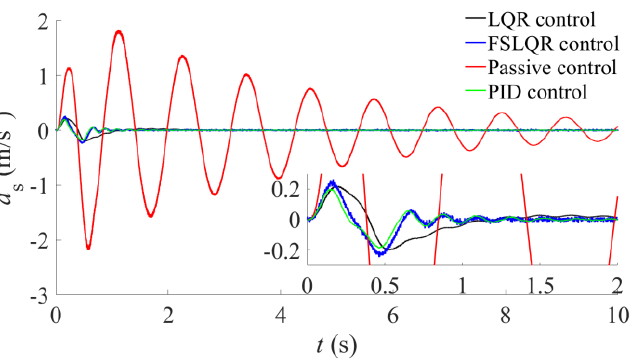
Figure 5. The sprung mass ’ s acceleration responses under the impulse excitation.